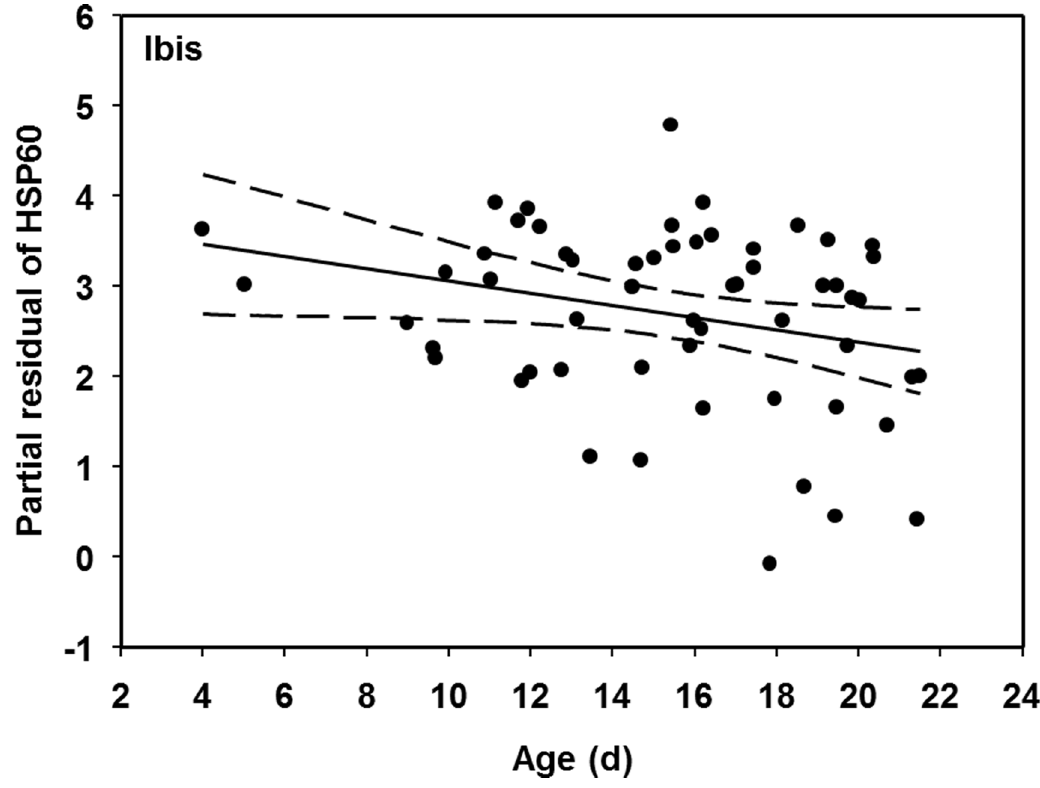
Figure 4. Relationship between partial residuals of HSP60 (ng/ml) and chick age (days) for white ibis chicks in the Florida Everglades, after accounting for other model variables. Dashed lines indicated 95% confidence